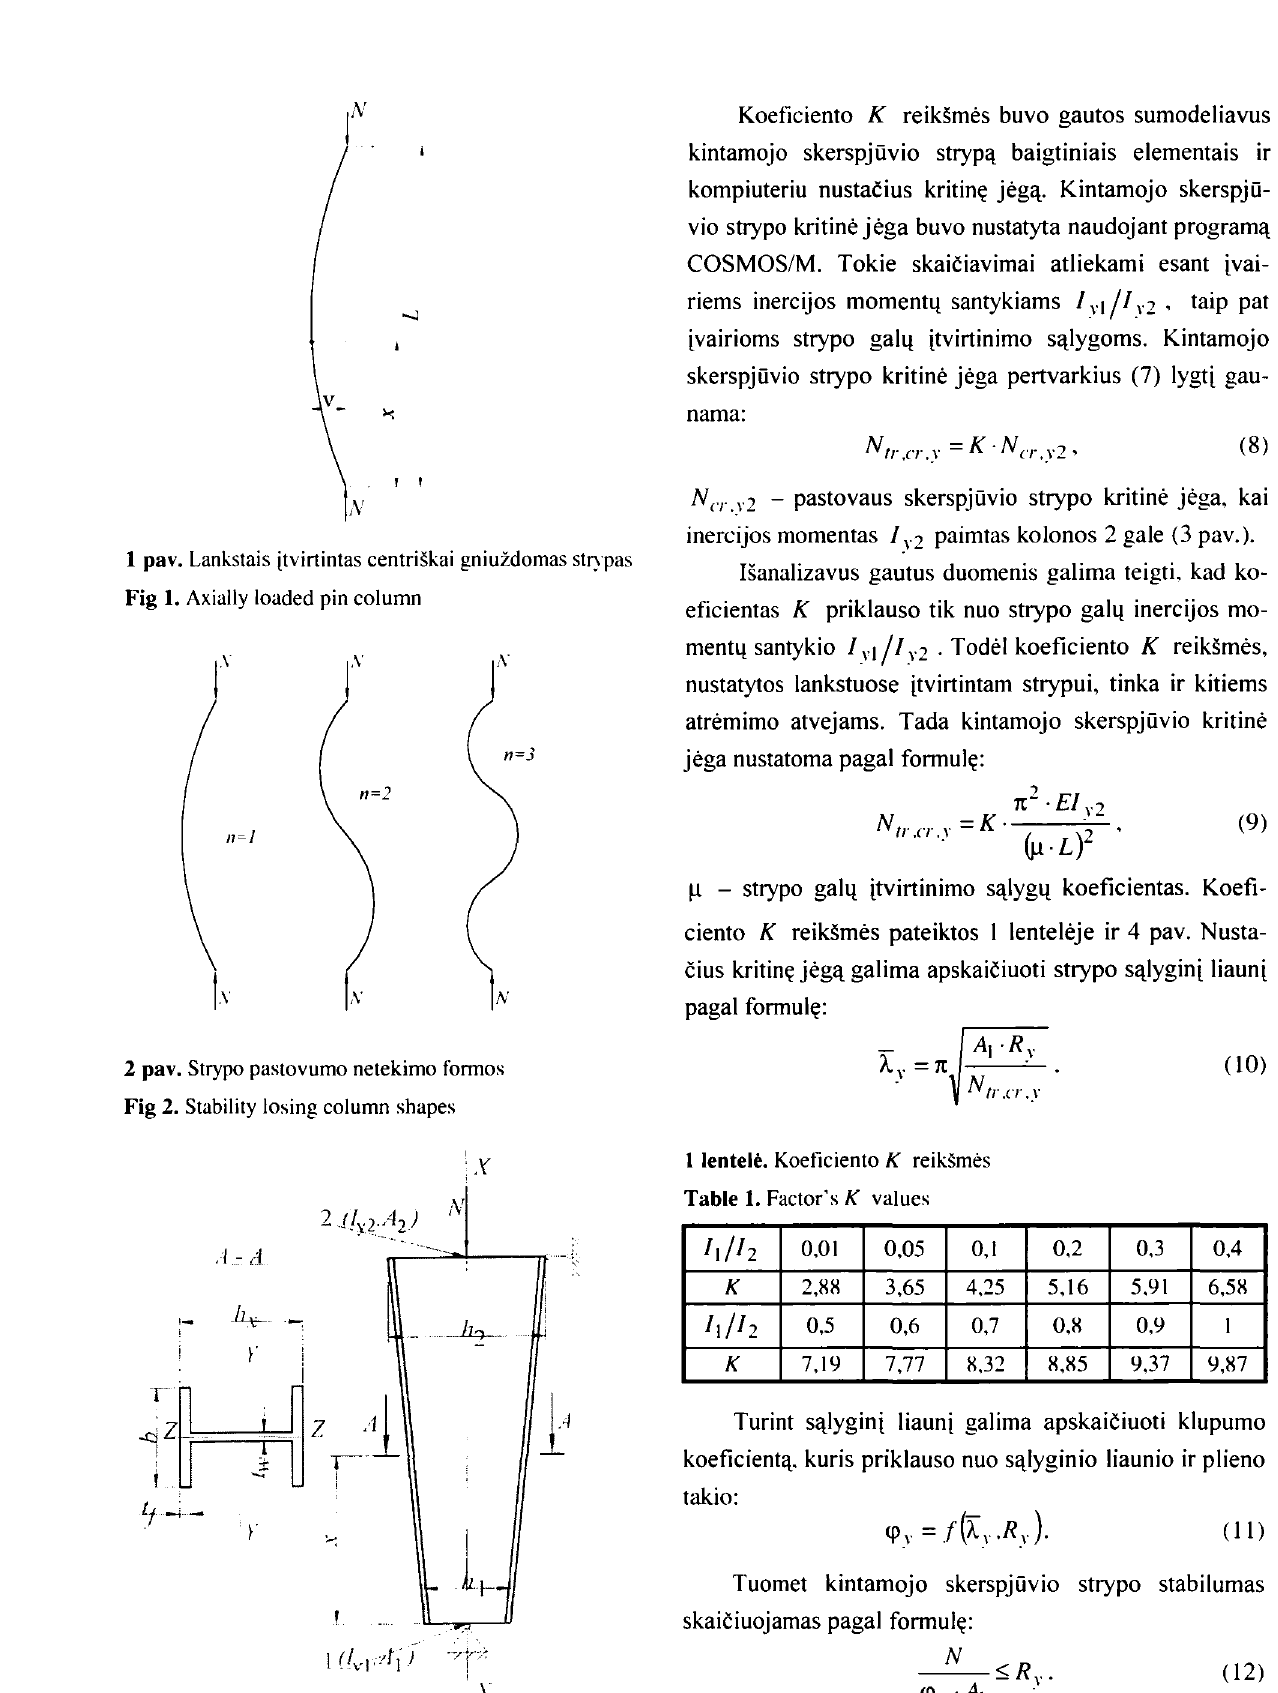
Table 1. Factor's K